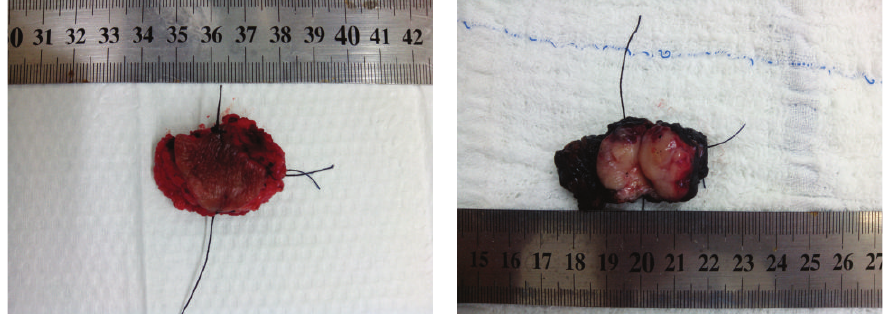
Figure 2: Excisional specimen of the vulvar proximal-type ES measuring 3.6 × 2.5 in size and 2.1cm in